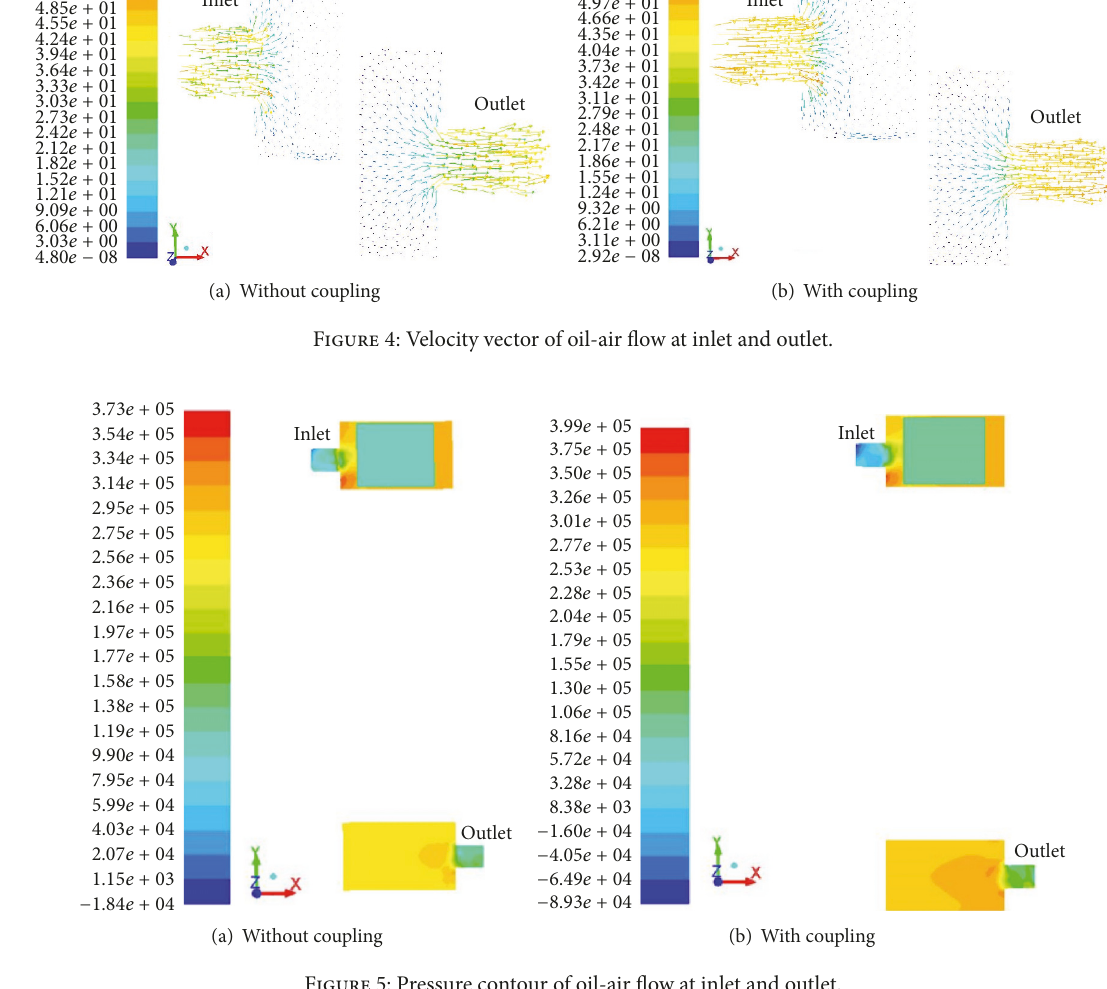
Figure 5: Pressure contour of oil-air flow at inlet and